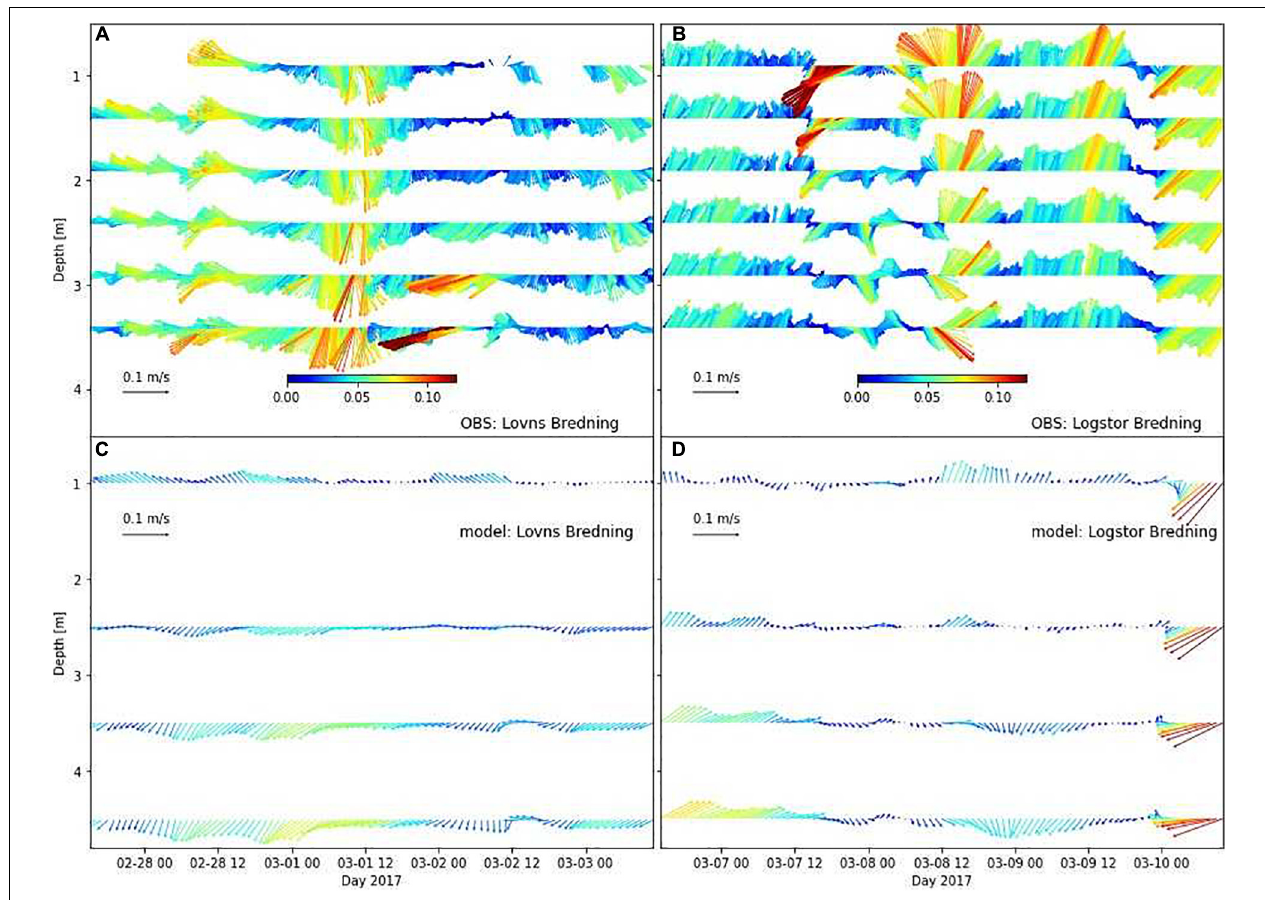
FIGURE 11 | ADCP time series (top) of instantaneous currents (every 40th ensemble is shown corresponding to 10 min intervals) and simulated instantaneous current profiles (below) at Lovns Bredning (A,C) and Løgstør Bredning (B,D)